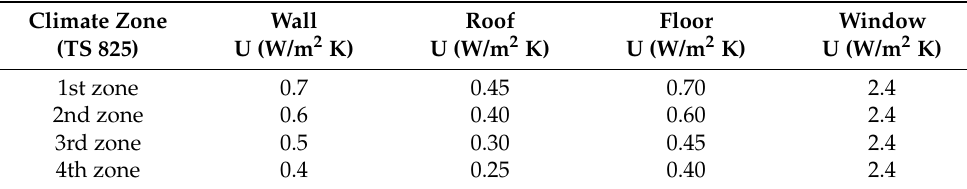
Table 1. Maximum U-value requirements (TS 825).